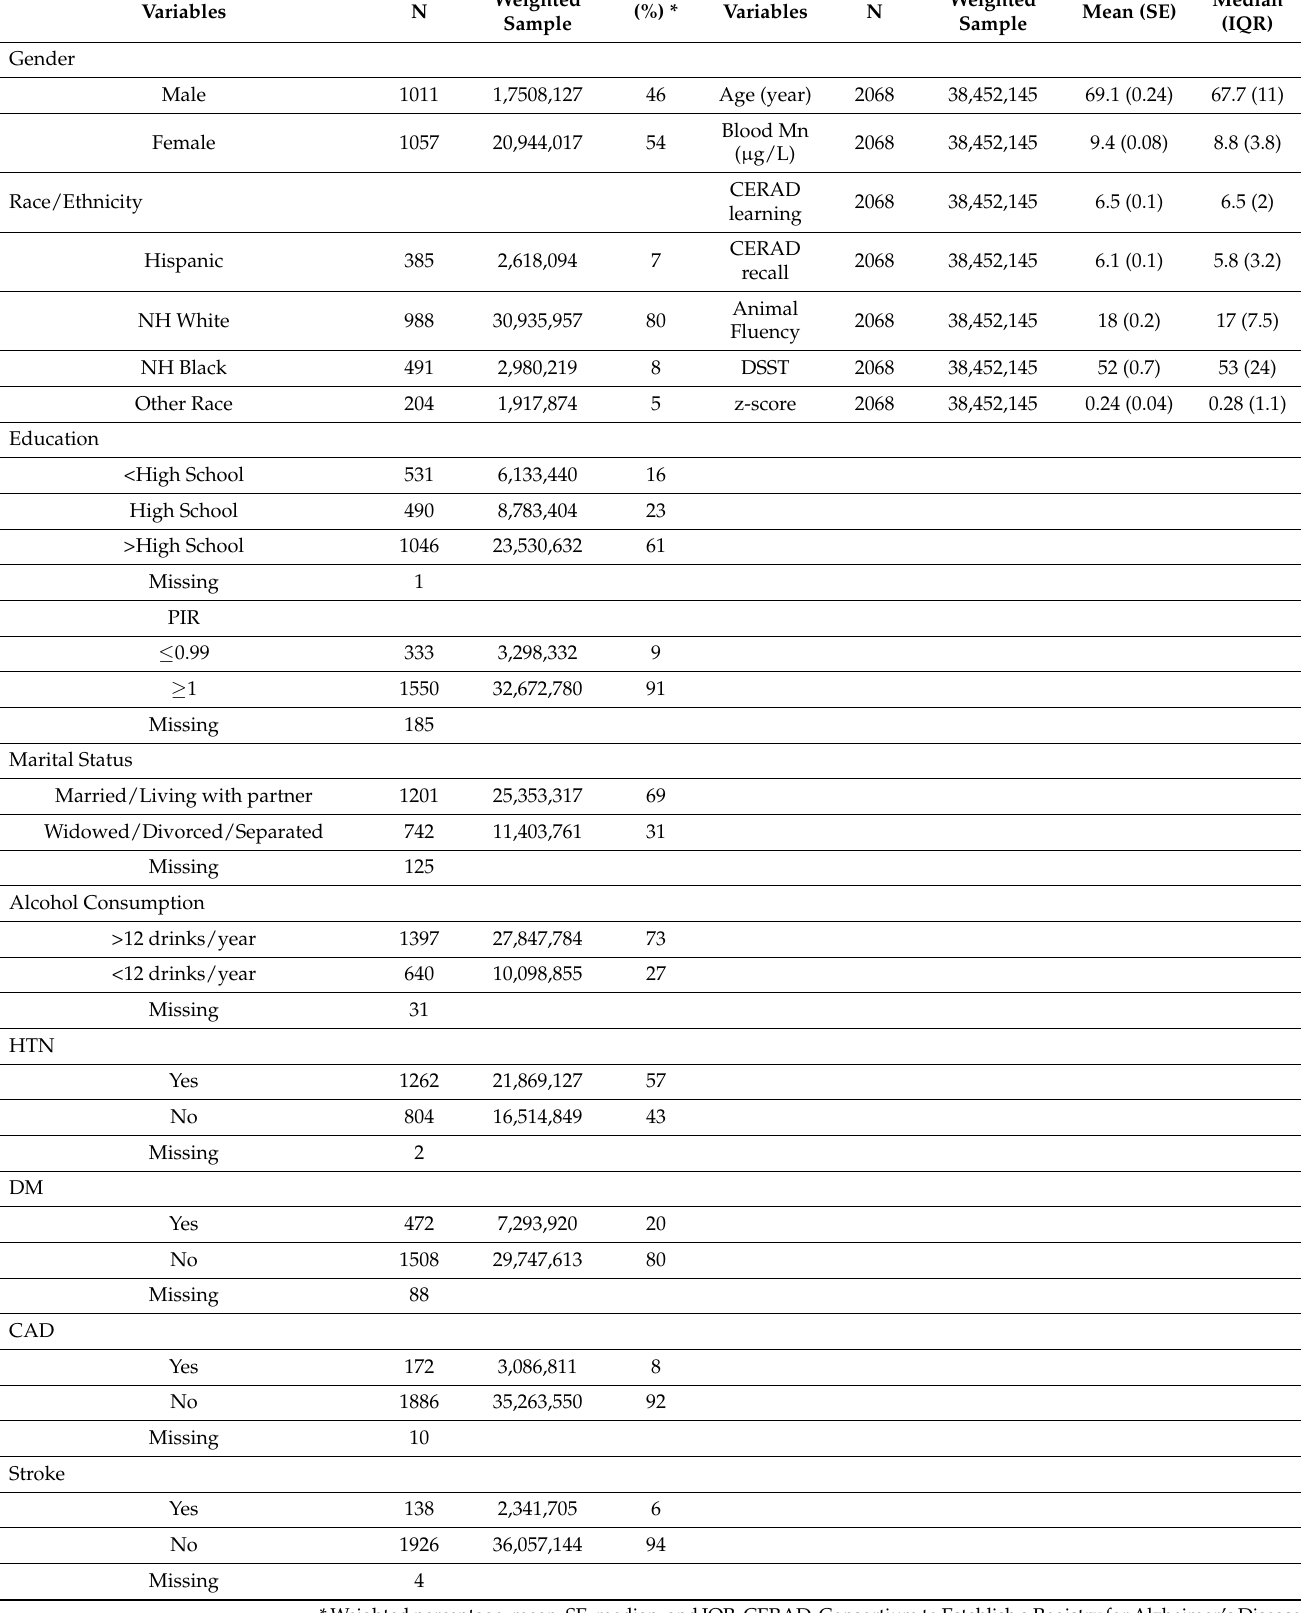
Table 1. Characteristics of the Mn-Blood study population ( n =